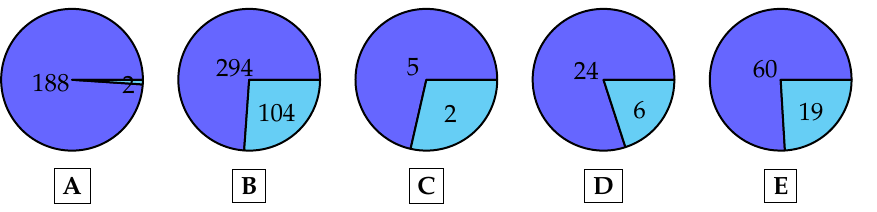
Figure 18. Experiment 2—true positives (blue), false positives (cyan). See Table 4.